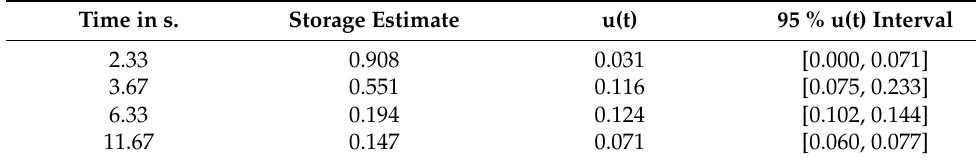
Table 9. Estimates for u ( t ) for data from experiment 1 in [17]. Time in